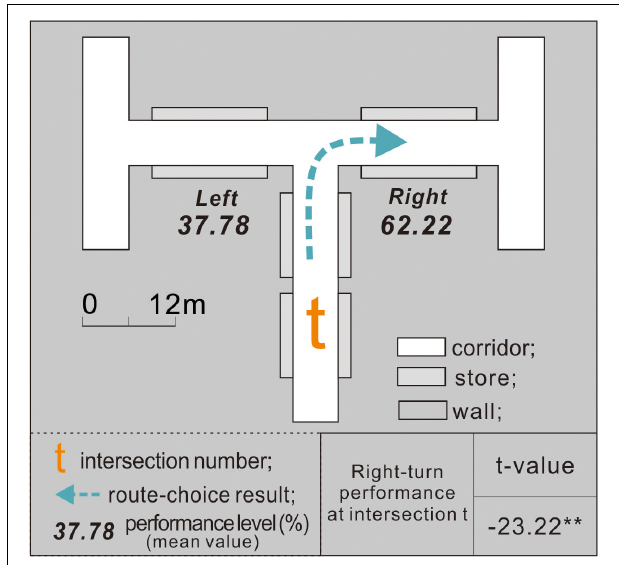
(at control condition intersection t ) to 72.99%. Such an increase in the right-turn performance indicated that broader corridors increased the original preference of exit-finders for right